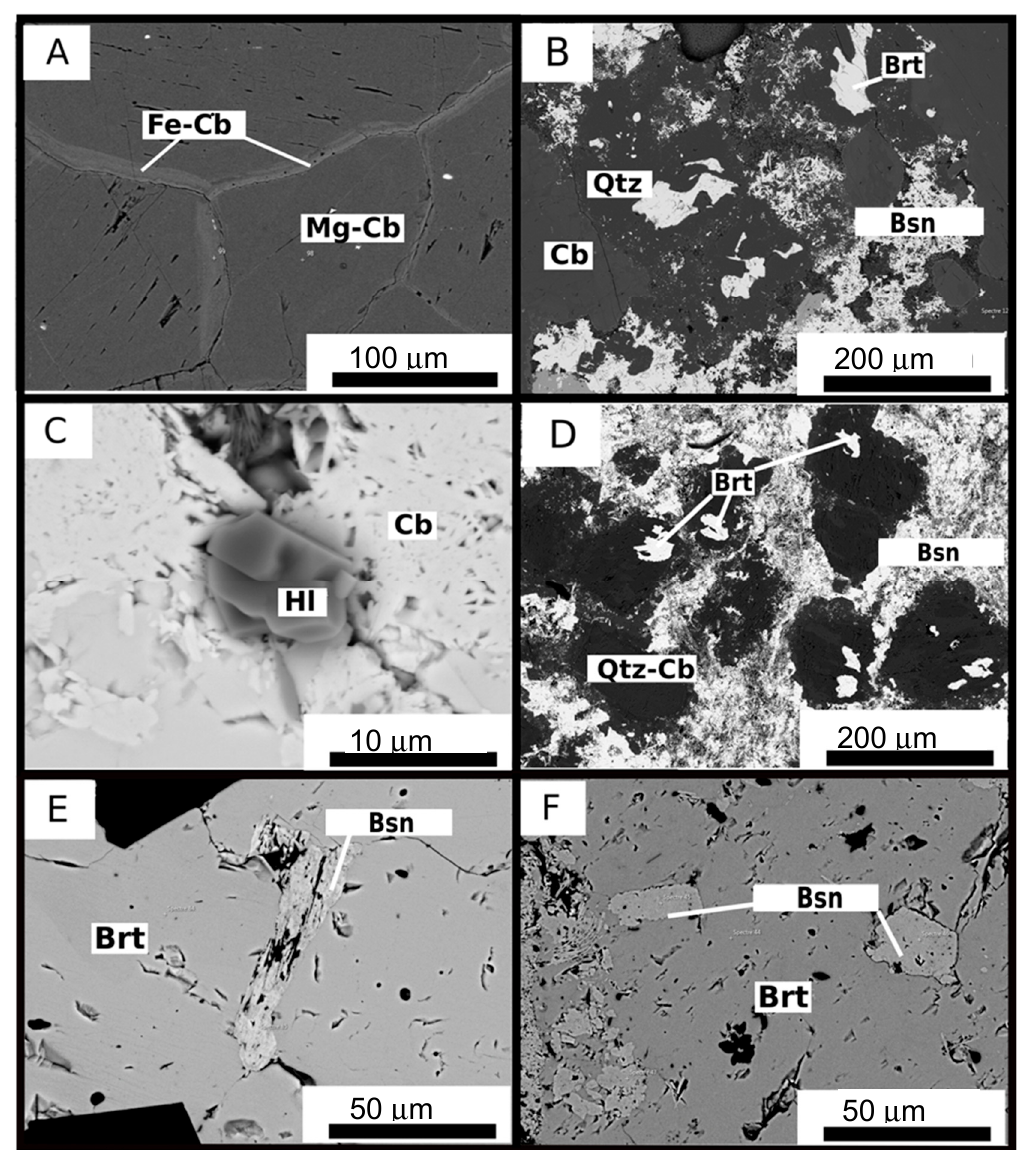
Figure 5. Selected SEM images of barite, carbonates, and halite by increasing depth: ( A ) Dolomite (Mg–Cb) with ankerite (Fe–Cb) rims from a depth of 350 m; ( B ) Relic barite crystals showing dissolution in quartz and calcite in a REE-fluorocarbonate matrix from a depth of about 400 m; ( C ) A small halite (Hl) crystal with carbonates from a depth of about 400 m; ( D ) similar texture than b) from a depth of about 650 m; ( E ) Barite from a depth of about 800 m with elongated bastnäsite-(Ce) crystal; ( F ) Barite from deeper than ( B , D ) (about 1100 m) with 50 μ m bastnäsite-(Ce) inclusions, some of which are subidiomorph. Cb = carbonate; Mg-Cb = dolomite; Fe–Cb = ankerite; Brt = barite; Bsn = REE- bastänasite-(Ce); Hem = hematite; HI = halite; Qtz = quartz. These images are representative of all drill cores and not only the deepest one used for geochemistry.